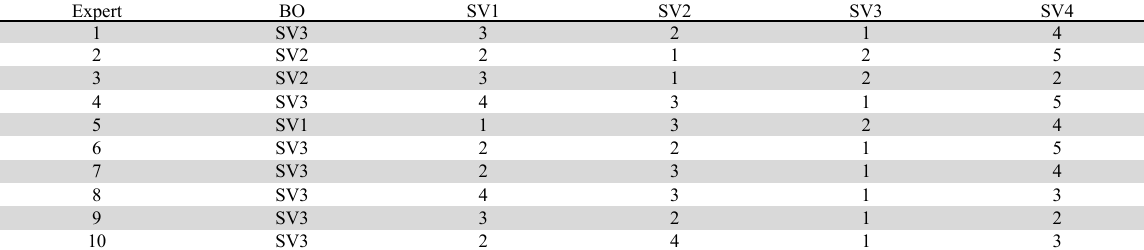
Strategic value preferences (Best to others) Expert